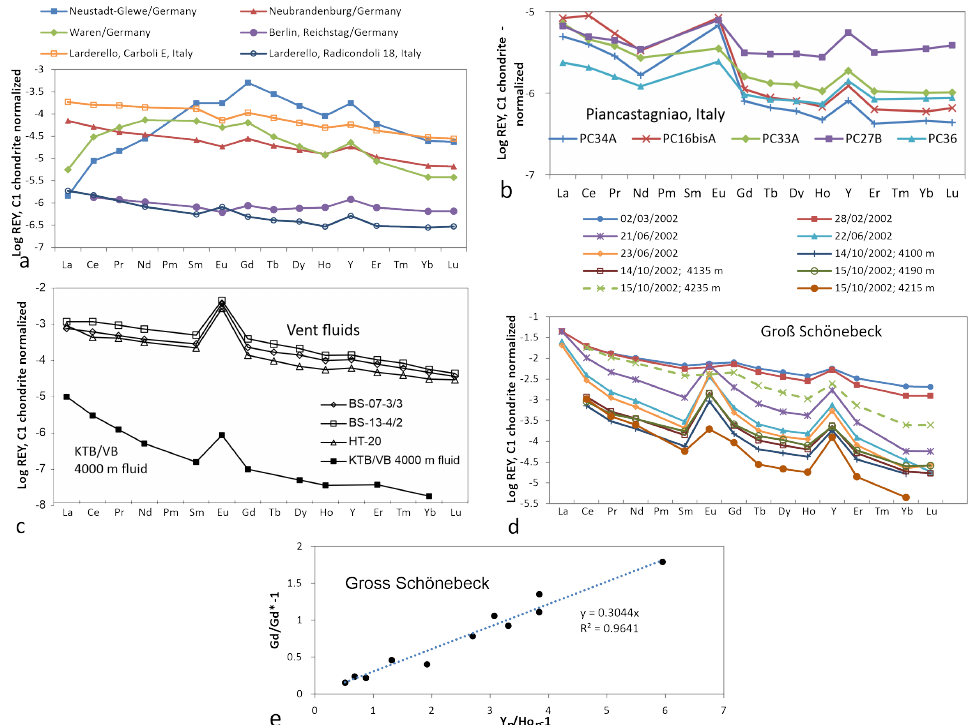
Figure 10. Geothermal well water. ( a ) Brines from wells Neustadt-Glewe, Neubrandenburg and Berlin (Germany, NWGB; refs. [78,79]; Paran in the Arava Valley, Israel [83]; condensed steam in Larderello/Travale, Italy [81]; ( b ) condensed steam in Mt Amiata, Italy [84]; ( c ) geothermal project Groß Schönebeck before (upper two patterns) and after fracking (lower four patterns) of Rotliegend conglomerates and Rotliegend sandstones [85]; ( d ) Vent fluids from the Mid-Atlantic Ridge [86,87] and REY patterns of the German Continental Deep Drilling Project KTB/VB 4000 m fluid from Devonian amphibolites [88]. ( e ) Correlation of Gd and Y anomalies in brines from the geothermal well Groß Schönebeck/Germany showing the effect of fracking with a common slope of